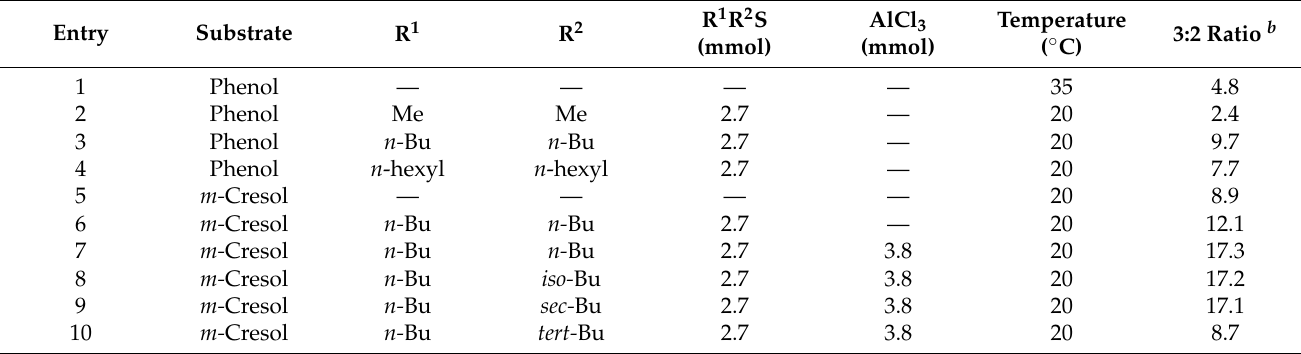
Table 1. Effect of dialkyl sulphides 5 (R 1 SR 2 ) on the selectivity of chlorination of phenols according to Scheme 1 a